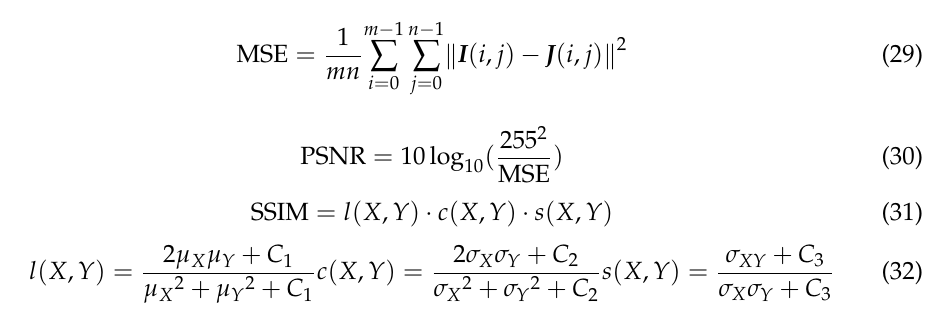
Figure 4. Ten experimental test images: ( a ) Cameraman, ( b ) House, ( c ) Peppers, ( d ) Starfish, ( e ) Monarch, ( f ) Airplane, ( g ) Parrot, ( h ) Man, ( i ) Resolution chart, and ( j ) Camera test. PSNR and SSIM are defined